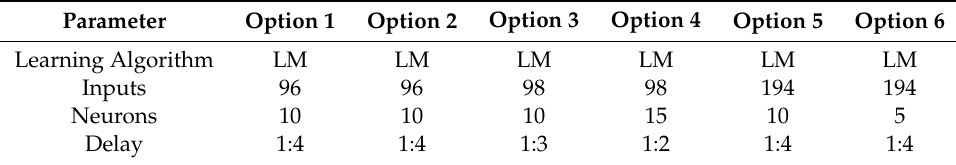
Table 9. Proposed options for the final energy forecaster.